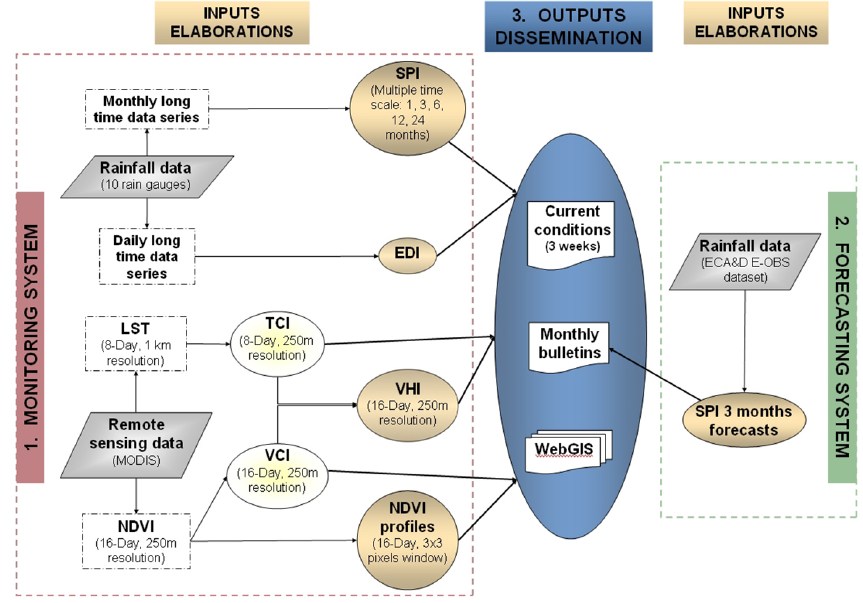
Figure 1. Schematic representation of the drought monitoring and forecasting system